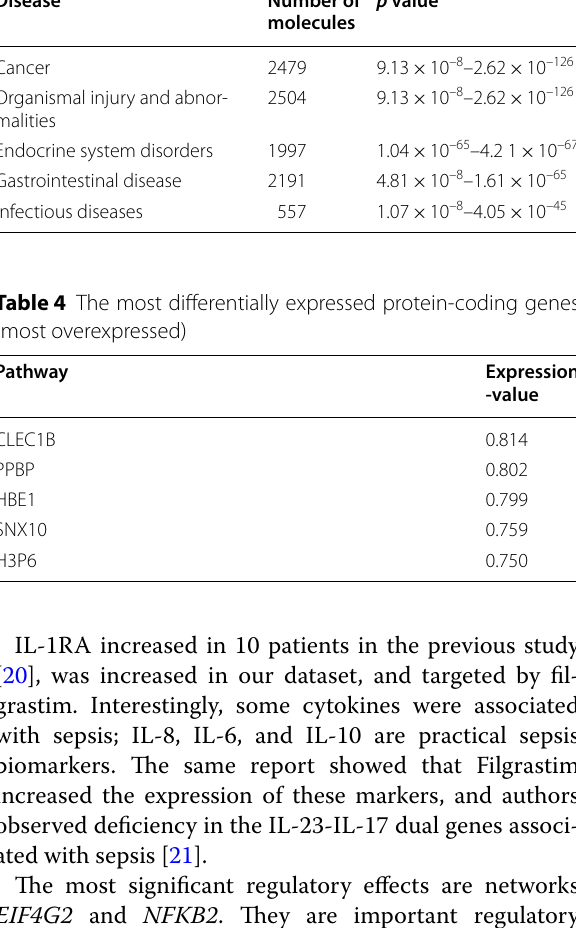
Table 3 Ingenuity pathway analysis found the top five illnesses Disease